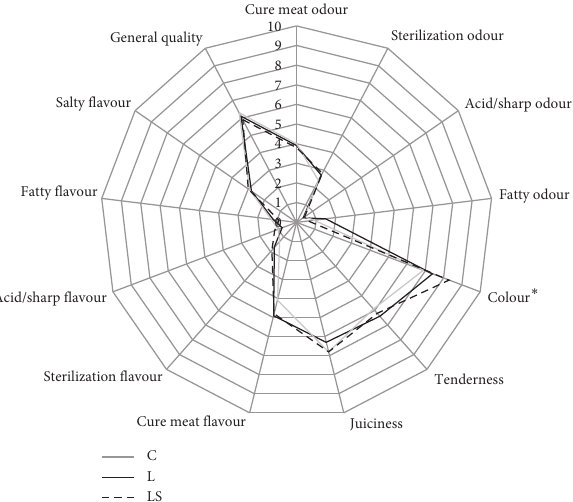
Figure 2: Sensory quality of model meat products after 8 weeks of refrigerated storage. C: control treatment, quantity added NaNO 2 100mg/kg; L: quantity added NaNO 2 —15 mg/kg; LS: quantity added NaNO 2 —15mg/kg+ S. carnosus ATCC 51365 in number 10 7 cfu/g. ∗ Mean values of this attribute significantly different ( P ≤ 0 . 05).